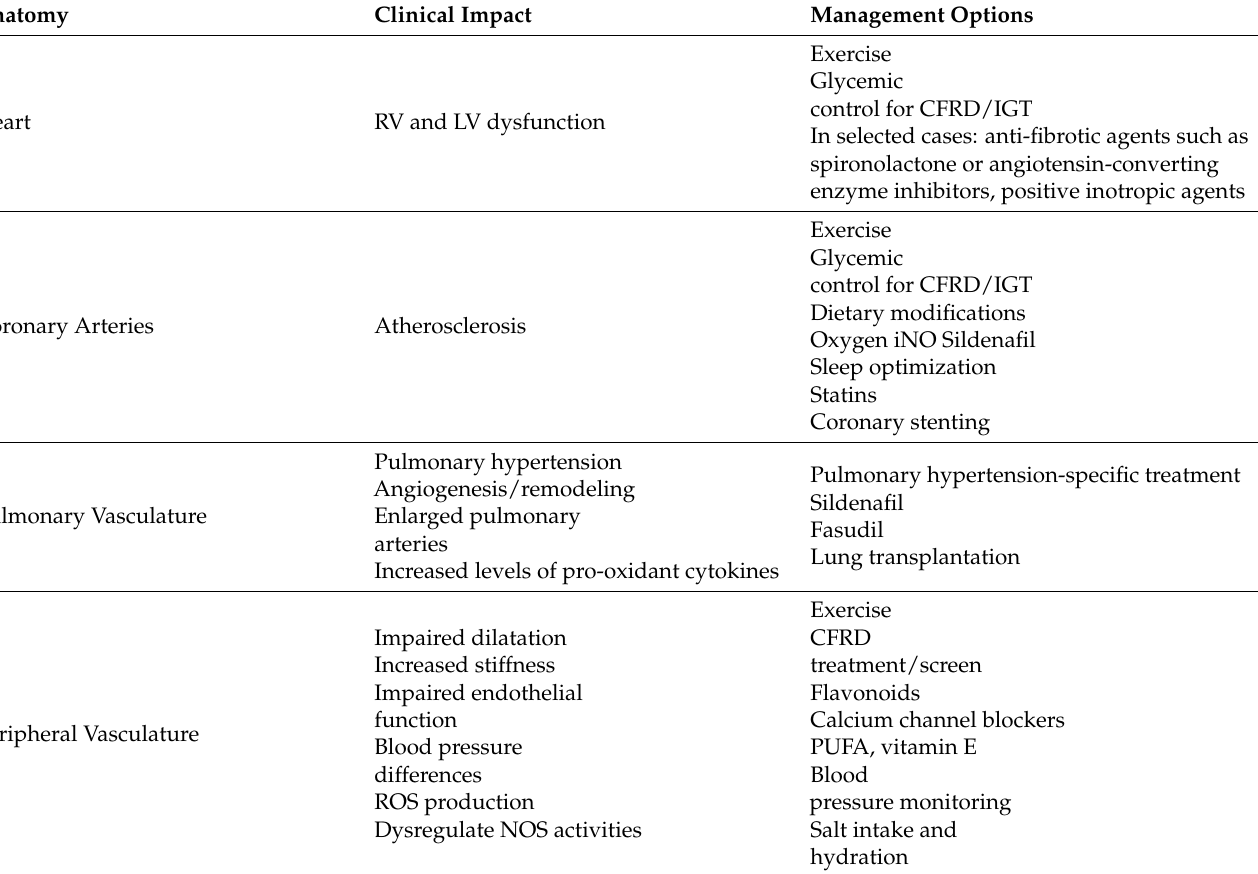
Table 1. Current understanding of CFTR presence, clinical impact, and potential management options for primary and secondary cardiovascular complications in CF adapted by Poore, Taylor-Cousar, and Zemanick, 2022 [1,9,18–20] (CF: cystic fibrosis, RV: right ventricle; LV: left ventricle; CFRD: cystic fibrosis-related diabetes; IGT: impaired glucose tolerance; iNO: inhaled nitric